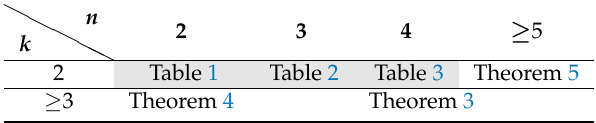
Table 4. References for the lower bounds for P c ( n , k , s ) and P w ( n , k , s ) . The gray cells refer to exact values.